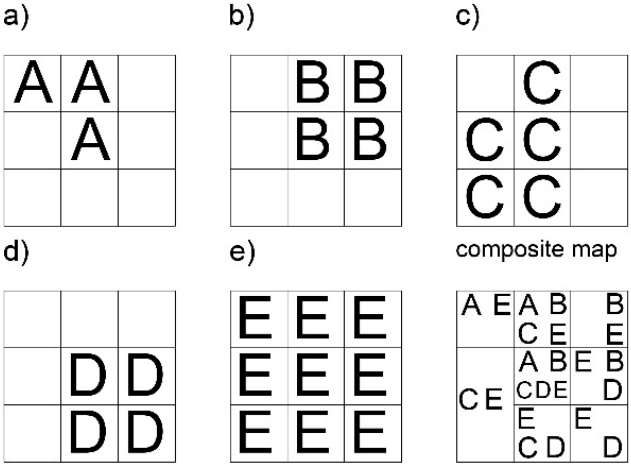
Figure 2. Gray’s conceptual model for making a composite map [27]. Figures ( a ) to ( e ) demonstrate “atom fields in concept” [27] p. 146.